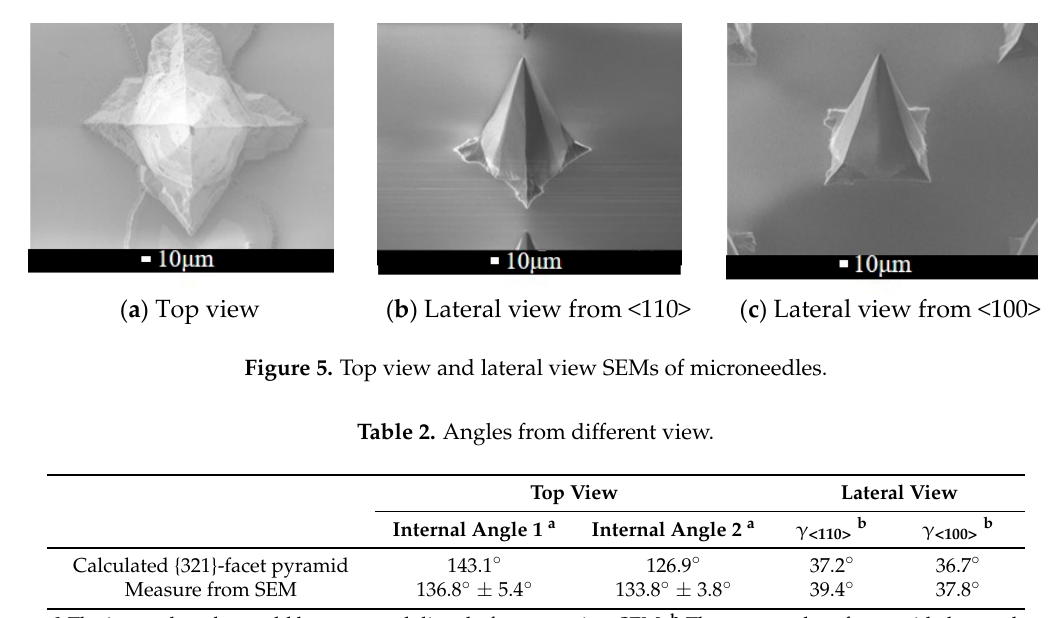
Figure 5. Top view and lateral view SEMs of microneedles.